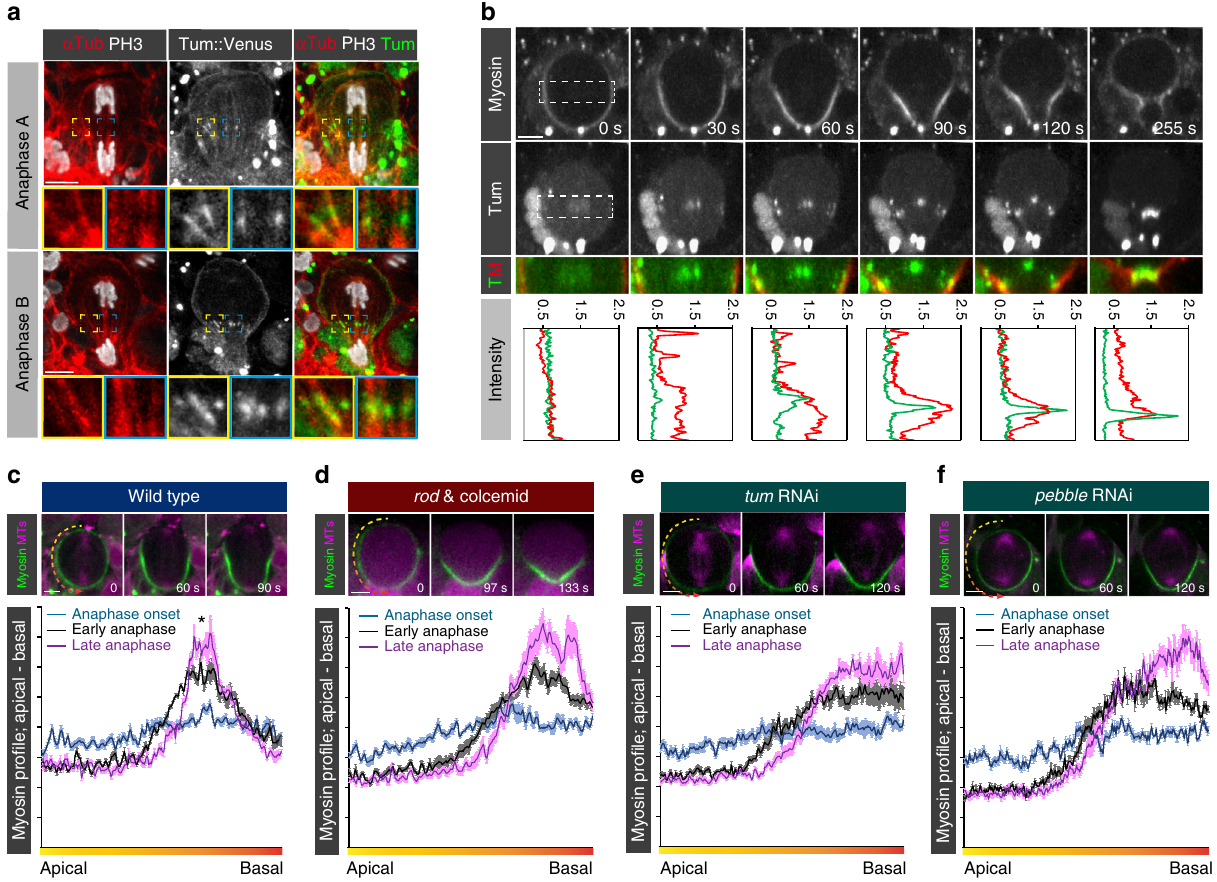
Fig. 4 The centralspindlin complex induces basolateral Myosin enrichment, necessary for basal Myosin relocalization. a Representative wild-type neuroblasts expressing Tum::Venus (white; middle row, green; overlay), and stained for alpha-Tubulin ( α Tub; red) and phospho-Histone3 (PH3; white in fi rst and third row). Higher magni fi cation images correspond to regions highlighted with yellow and blue squares. b Representative image sequence of a wild-type neuroblast expressing Myosin (white; top row, red; overlay in third row) and Tumbleweed (white; second row, green; overlay in third row). Higher magni fi cation pictures were taken from the regions highlighted with white dashed boxes and shown as a merge (third row). Myosin (red) and Tumbleweed (green) intensity plots, obtained from the apical to the basal cortex, are shown for each time point. Representative image sequences of third instar neuroblasts expressing Sqh::GFP (Myosin; green) and Cherry::Jupiter (MTs; purple) for ( c ) wild type, ( d ) colcemid-treated rod mutant, ( e ) Tum or ( f ) Pebble depleted neuroblasts. Myosin intensity was measured from the apical to the basal neuroblast cortex at three different time points. For all conditions, the mean intensity, derived from 5 cells and standard deviation is plotted. The data were collected from at least 3 independent experiments. The star corresponds to the lateral Myosin enrichment detected in early anaphase in wild-type neuroblasts. Scale bars: 5 µ m recovery dynamics than simultaneously bleached Sqh::GFP (Supplementary Fig. 2f – i), which was expected for a membrane- associated protein not restricted in its lateral movement by the actin cytoskeleton 28, 29 . Myosin fl ow velocity quanti fi cations from kymographs revealed values comparable to the photoconversion data sets (Apical — Basal: 196.7+/ − 84.3 nm/s, n = 26; Basal — Apical: 187.3+/ − 68.9 nm/s, n = 26; Fig. 2f). Overall, the two converging Myosin fl ows showed no statistically signi fi cant